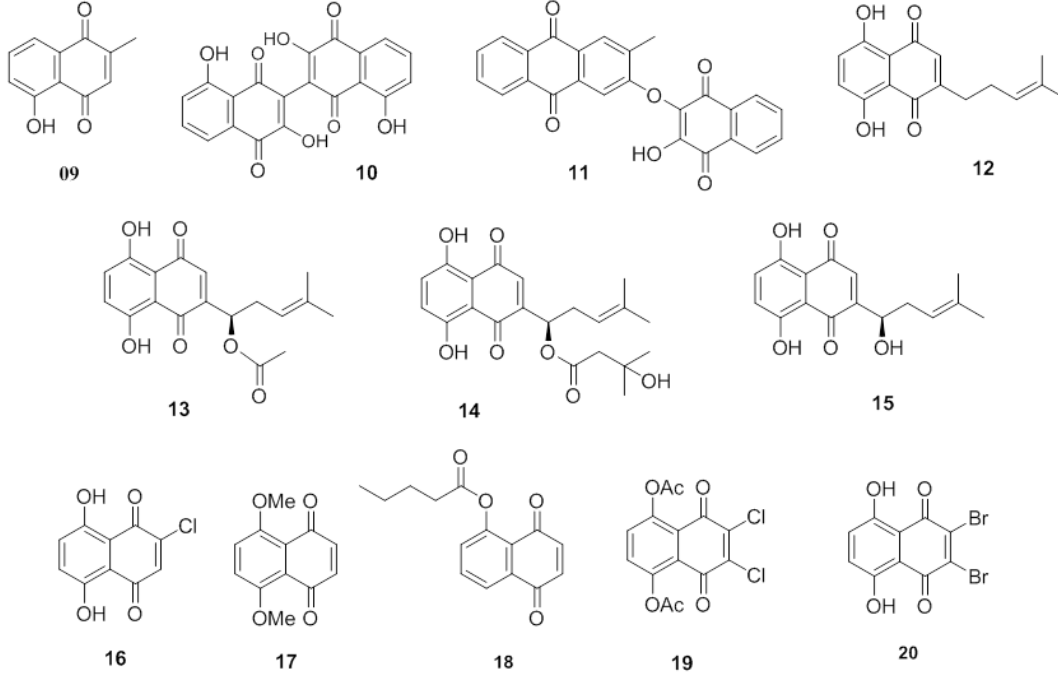
Figure 3 – Some naphthoquinones active against C. krusei and C. parapsilosis